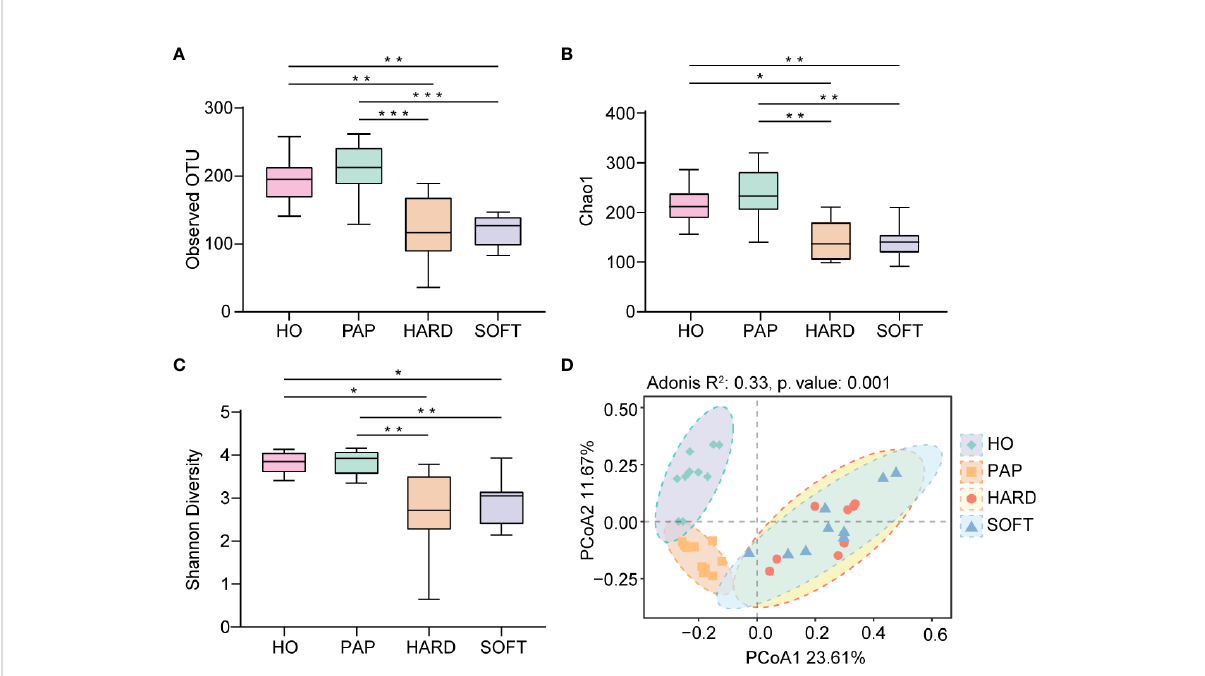
FIGURE 4 Comparison of diversity indices between HO and different stages of AP based on 16S rRNA sequencing data. (A) Observed OTUs, (B) Chao1 index, and (C) Shannon diversity index indicate the decrease of alpha diversity in persistent AP compared with HO and PAP. (*p < 0.05, **p